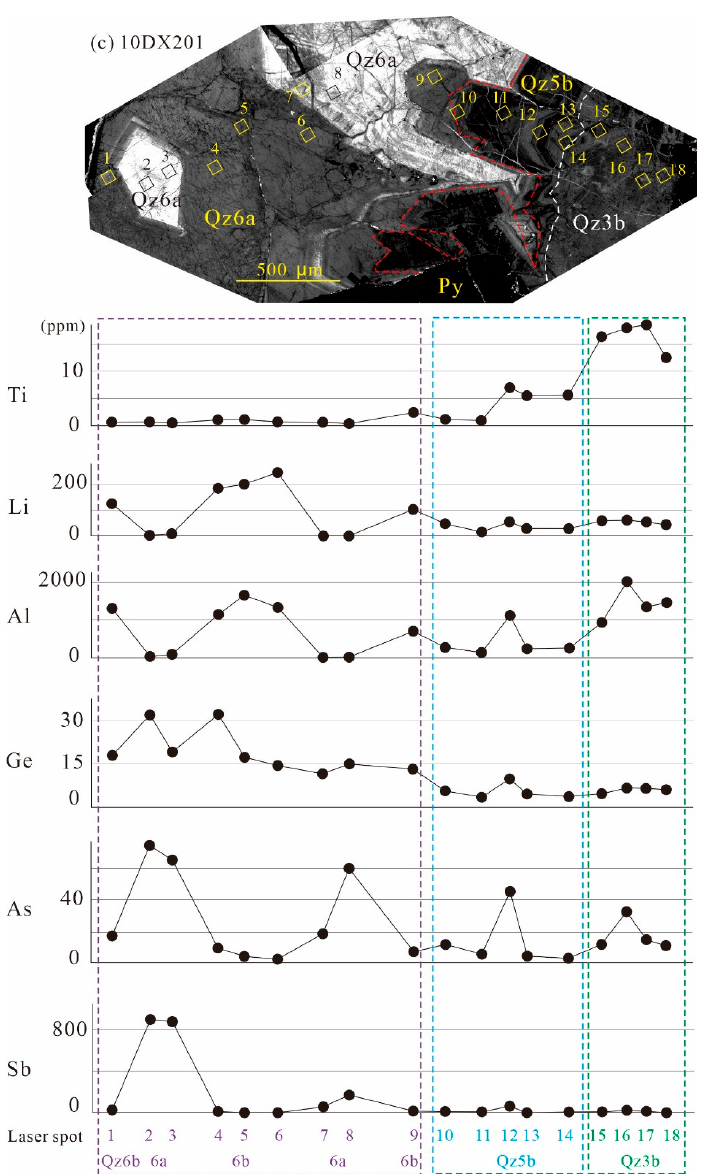
Figure 9. Sketches showing quartz CL textures and ablation spots for trace elements. ( a ) B.V cpq vein crosscutting the A.V qd vein (12LDX37). Qz1 had intermediate Ti contents (20–30 ppm); Qz2 had higher Ti contents (50–70 ppm). Note that Cu-Fe sulfides coprecipitated with Qz4, which reopened Qz2 grains. Qz2 grains, in turn, crosscut Qz1 grains; ( b ) In D.V pd pyrite veins (10DX140), Qz3 had lower Ti contents (10–20 ppm) compared to earlier quartz; ( c ) A profile of trace element analyses encompassing Qz3, Qz5, and Qz6 (10DX201). Qz5 had variable yet lower Ti contents (1–15 ppm). Qz6a and Qz6b had elevated contents of Ge, As and Sb.